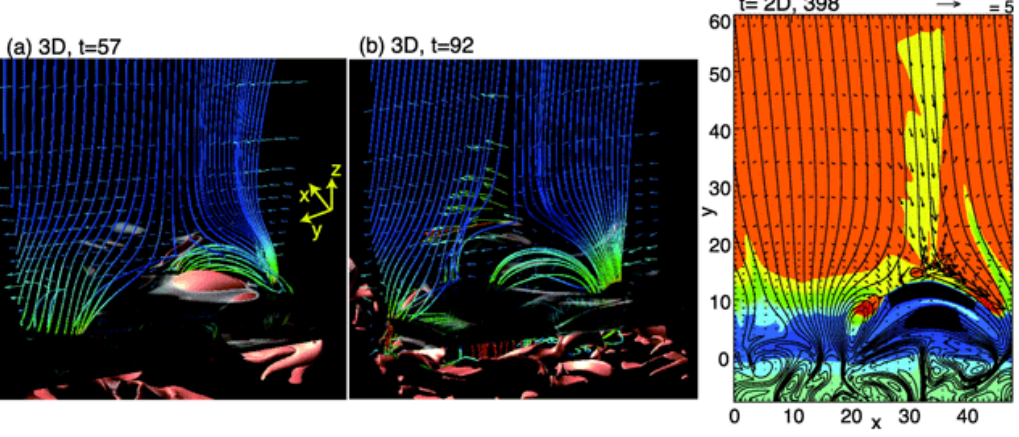
Figure 33: In the simulation of Isobe et al. (2008), the convectively-driven emergence of a granular-scale flux loop reconnects with ambient vertical field. Such reconnection events eject mass into the height atmo- sphere and provides an in-situ source of magneto-acoustic power (as opposed to waves propagating from photospheric base). The central and left panels show an example of such an event in a 3D magnetoconvec- tion simulation. The right panel shows a 2D counterpart. Image reproduced with permission, copyright by